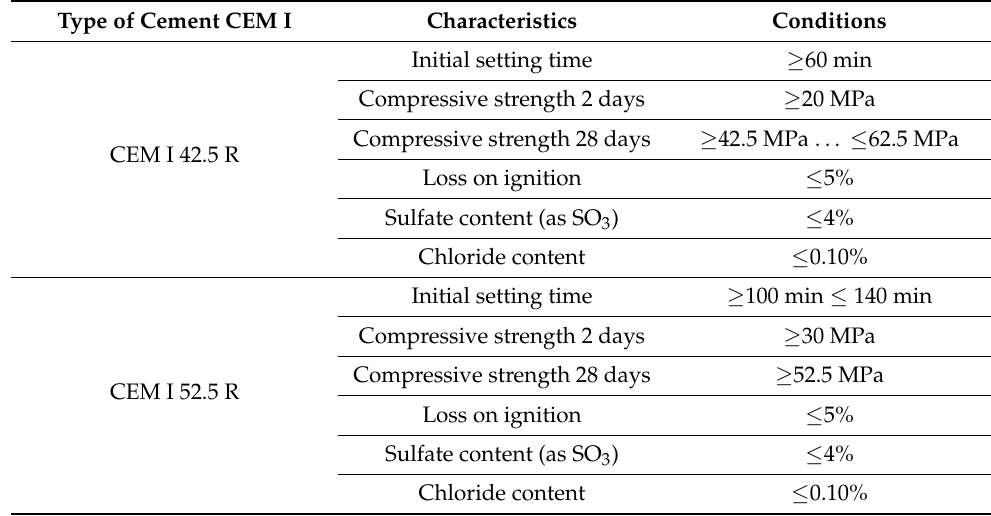
Table 3. CEM I characteristics [33].